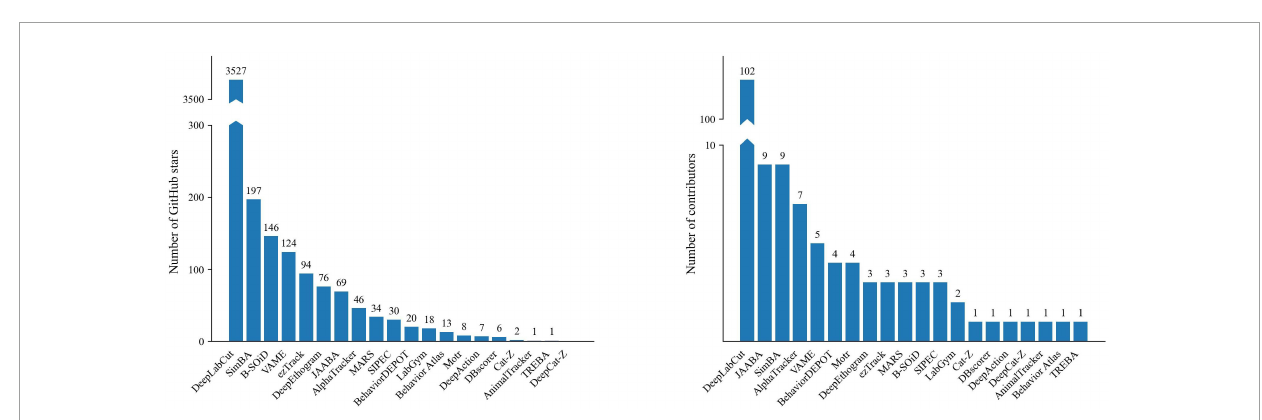
FIGURE1 Flowchart of the general capabilities of different tracking and behavioral analysis software.